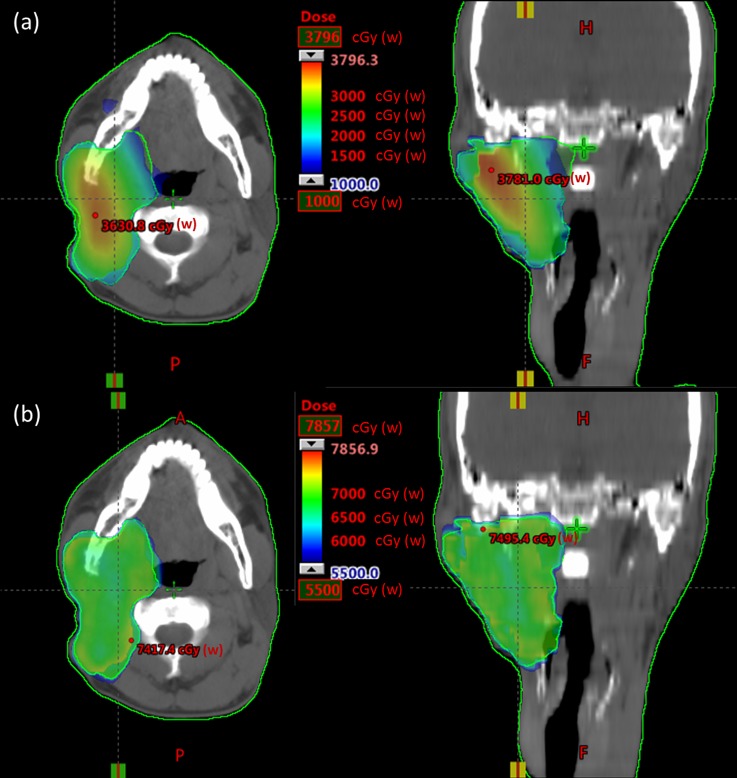
Representative isodose curves of GTV for the BNCT alone (a) in axial and coronal views and BNCT+IMRT (b) plans in axial and coronal views for a recurrent parotid gland tumor.